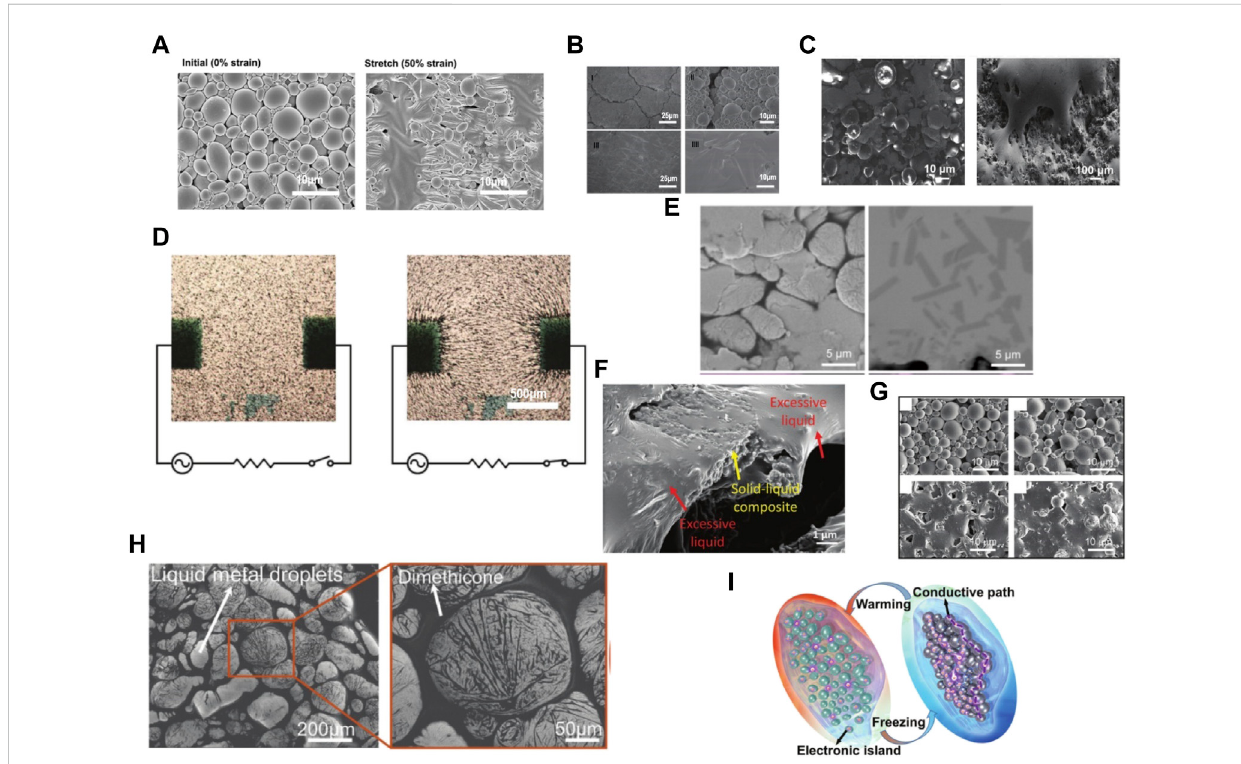
FIGURE 3 Sintered liquidmetal (A) Strain sinteredliquidmetal (TANGetal.,2019b) (B) Pressuresinteredliquidmetal (LINetal.,2015). (C) Heatedsinteredliquid metal (NIU et al., 2022). (D) Dielectrophoresis sintering of liquid metal (KRISNADI et al., 2020). (E) Chemical sintering of liquid metal (LI et al., 2020b) (F) SEMimageoflasersintering(DENGandCHENG,2019) (G) SEMcharacterizationoftheLMafterdifferentwet-drycycles(TANGetal.,2020) (H) Picturesof liquid metal microdrops show that the liquid metal droplets cannot contact each other at room temperature (CHEN et al., 2019) (I) Schematic diagram of the conductor-insulation transition of the materials (CHEN et al.,